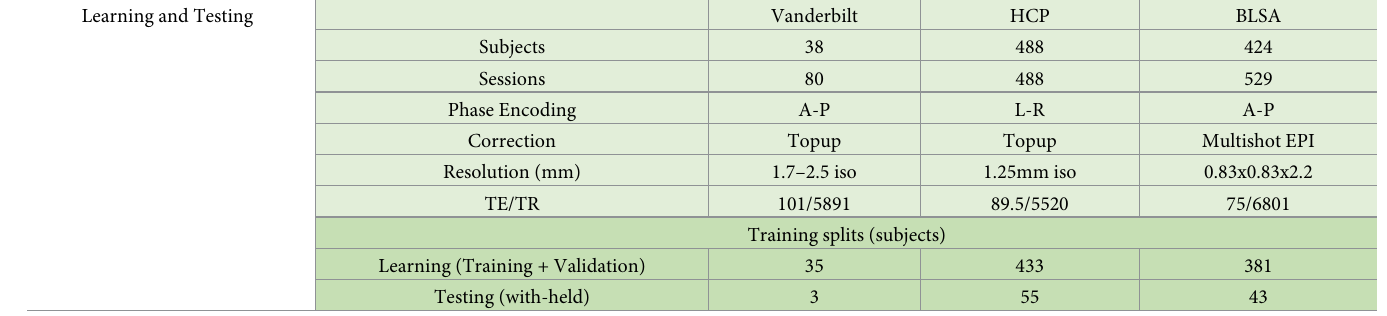
Table 1. Learning and